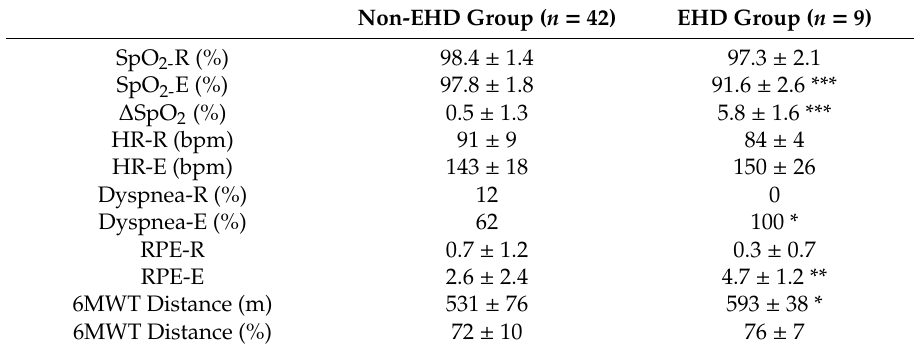
Table 3. Six minutes walking test (6MWT) responses of the patients according to exercise-related hemoglobin desaturation.